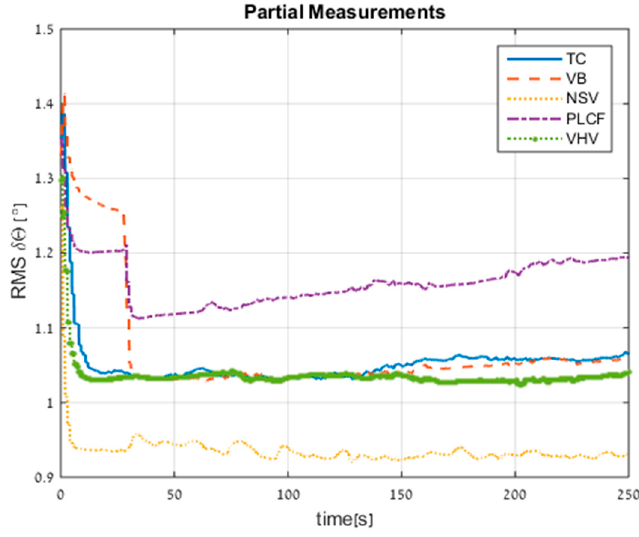
Figure 14. RMS errors of attitude for all approaches obtained from trajectory #3.